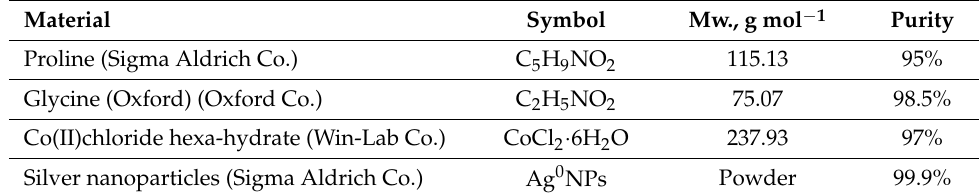
Table 1. Materials used in crystals